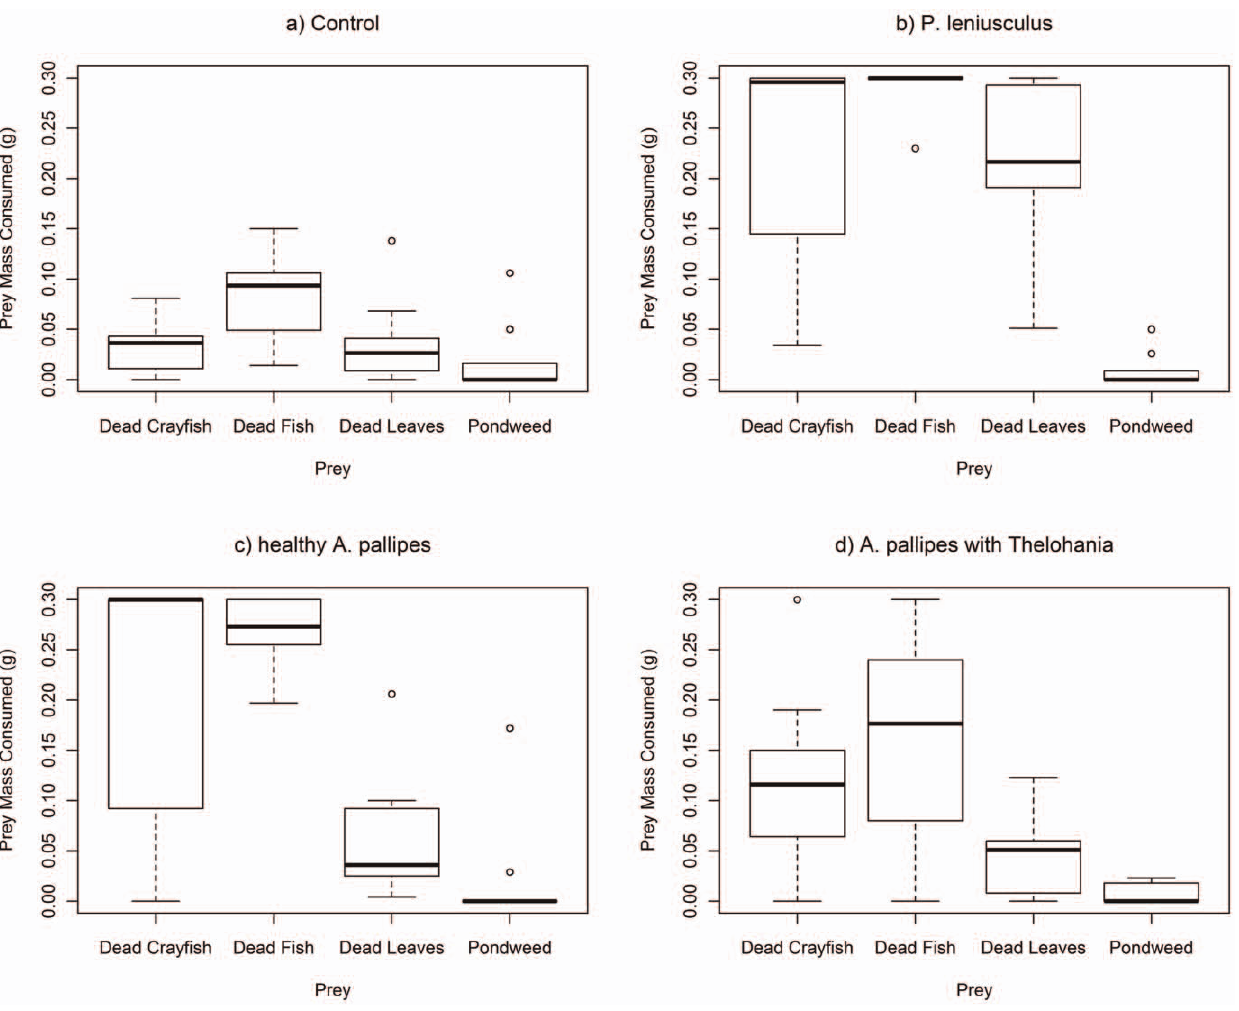
Figure 3. Prey consumption (g) by crayfish for non-mobile food items. Trials with P. leniusculus , healthy A. pallipes , A. pallipes with T. contejeani , and controls. Plots show medians (thick line), interquartile ranges (boxes) and data range (whiskers), with outliers as open circles.